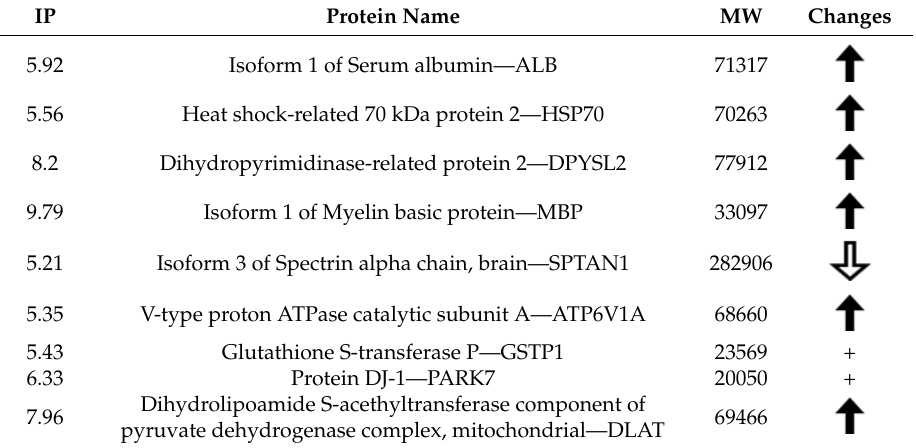
Table 1. Proteins differentially expressed in the hippocampus of patients with